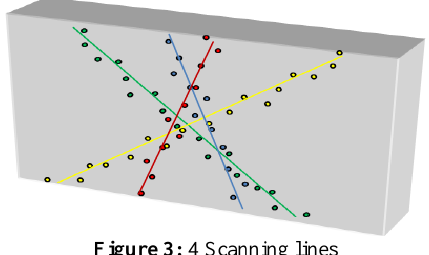
Figure 3: 4 Scanning